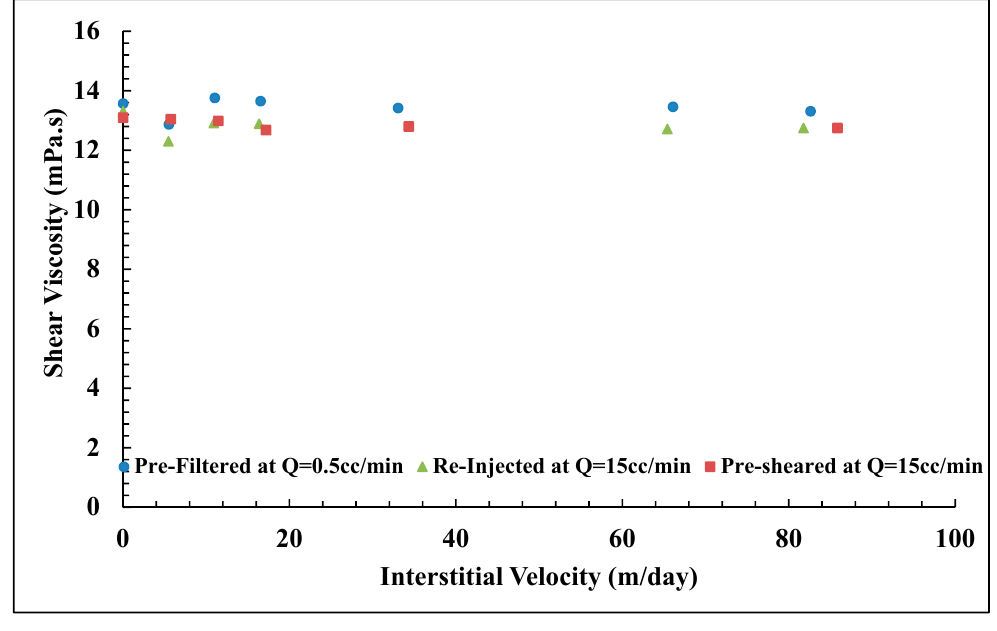
. γ = 10 s − 1 . Error bars are smaller than the